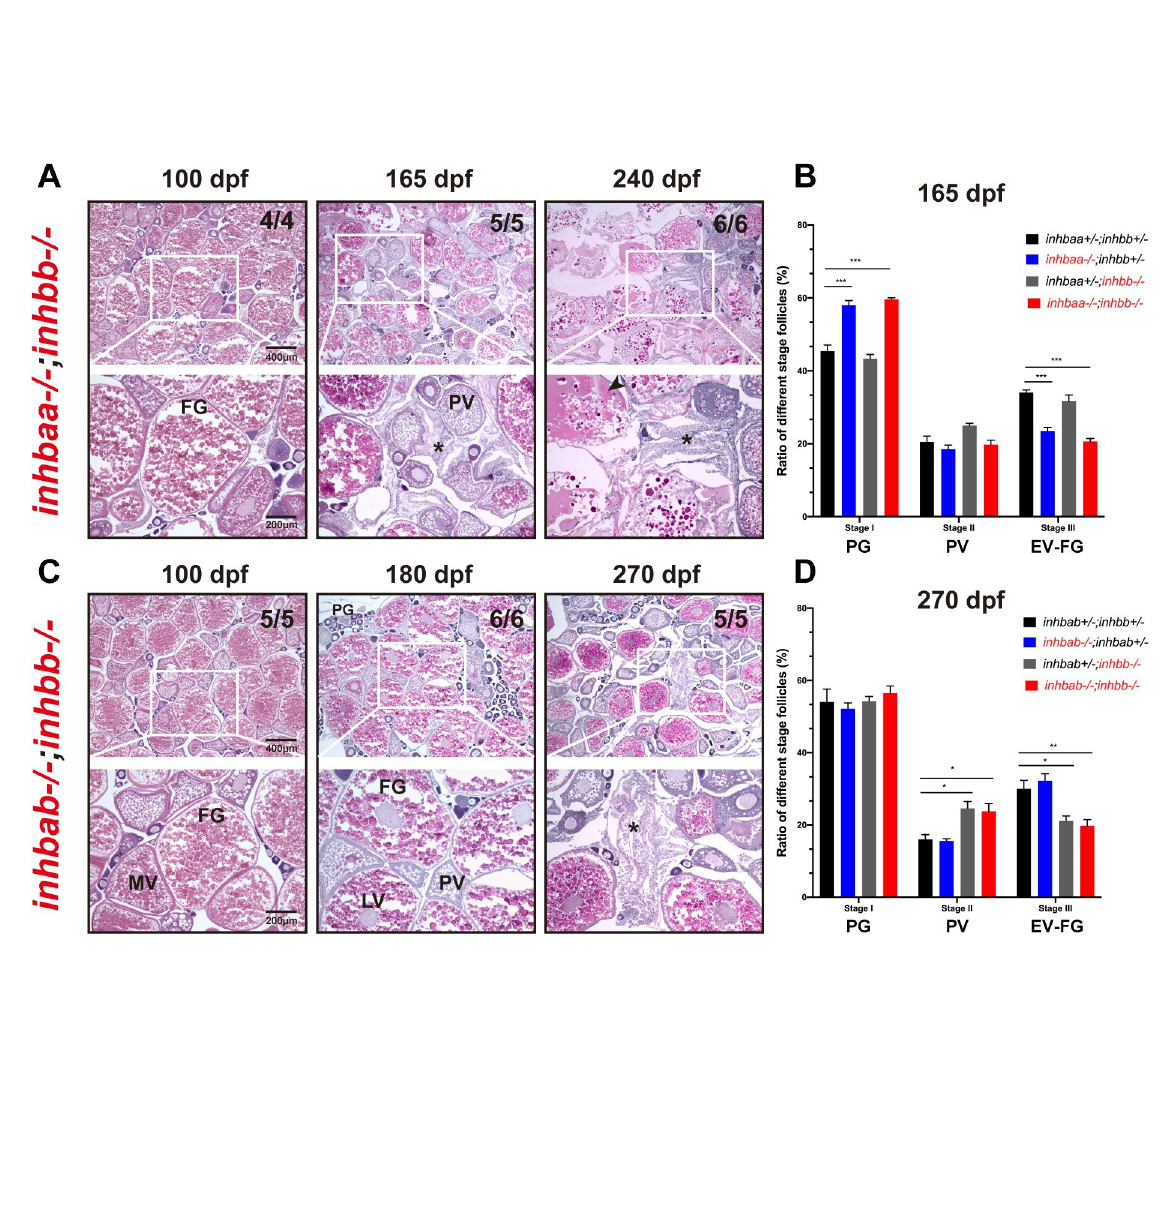
Fig 12. Phenotype analysis of β A and β B double mutants. Double mutants involving both β A and β B subunits were created ( inhbaa-/-;inhbb-/- , and inhbab-/-;inhbb-/- ) and their ovaries examined at different time points (100–270 dpf). (A) Histological analysis of inhbaa-/-;inhbb-/- from 100 to 240 dpf. (B) Follicle composition in the ovaries of the inhbaa;inhbb mutants at 165 dpf ( ��� p < 0.001, n = 4). (C) Histological analysis of inhbab-/-;inhbb-/- from 100 to 270 dpf. (D) Follicle composition in the ovaries of the inhbab;inhbb mutants at 270 dpf ( � p < 0.05; �� p < 0.01, n = 4). No interactive effects were observed between β A and β B in terms of histological structure and follicle composition. The double mutants phenocopied the single mutants inhbaa-/- and inhbb-/- , respectively, showing similar ovarian disorganization, follicle degeneration, and accumulation of somatic stromal cells (asterisk) and fluid (arrowhead) at 165 and 240 dpf for inhbaa-/-;inhbb-/- and 270 dpf for inhbab-/-;inhbb-/- . The numbers shown in the photos indicate the total number of fish examined (lower) and the fish exhibiting similar phenotype to that shown (upper). PV, pre-vitellogenic; MV, mid-vitellogenic; LV, late vitellogenic; FG, full-grown.